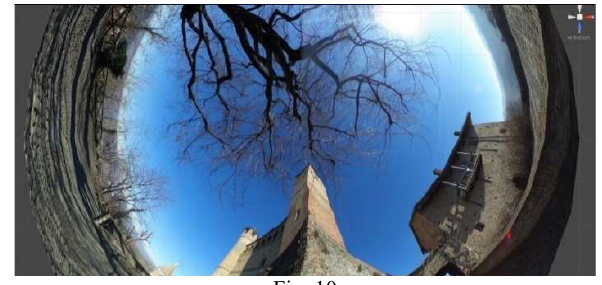
Therefore, the Unity skybox panoramic shader was used, which requires cube image conversion (Fig. 11).